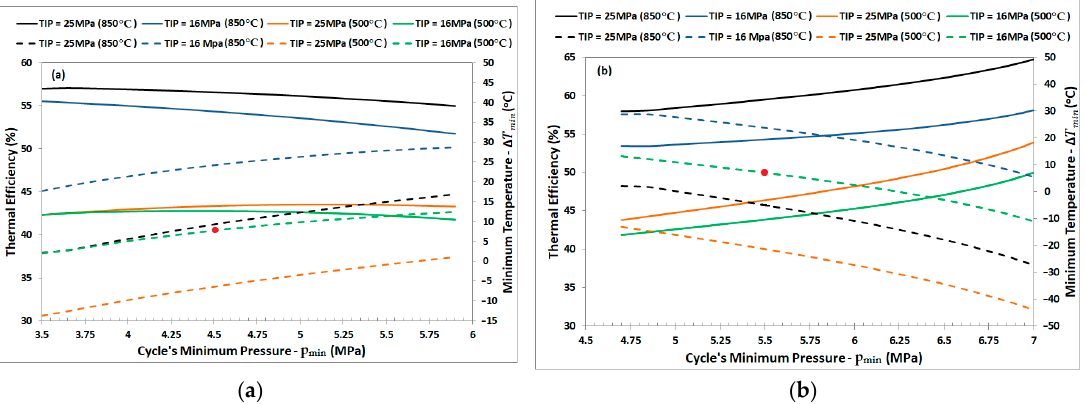
Figure 3. Cycle thermal efficiency (solid lines) and minimum pinch temperature in the heat exchanger (dashed lines) plotted as a function of the cycle’s minimum pressure (p ) for ( a ) RBC-PC and ( b ) RBC-PC-IHR. The turbine inlet pressure (TIP) was set to 25 MPa or 16 MPa for turbine inlet temperatures (TIT) of 850 °C and 500 °C. The red dot shows the near-optimal value for the cycle’s minimum pressure.